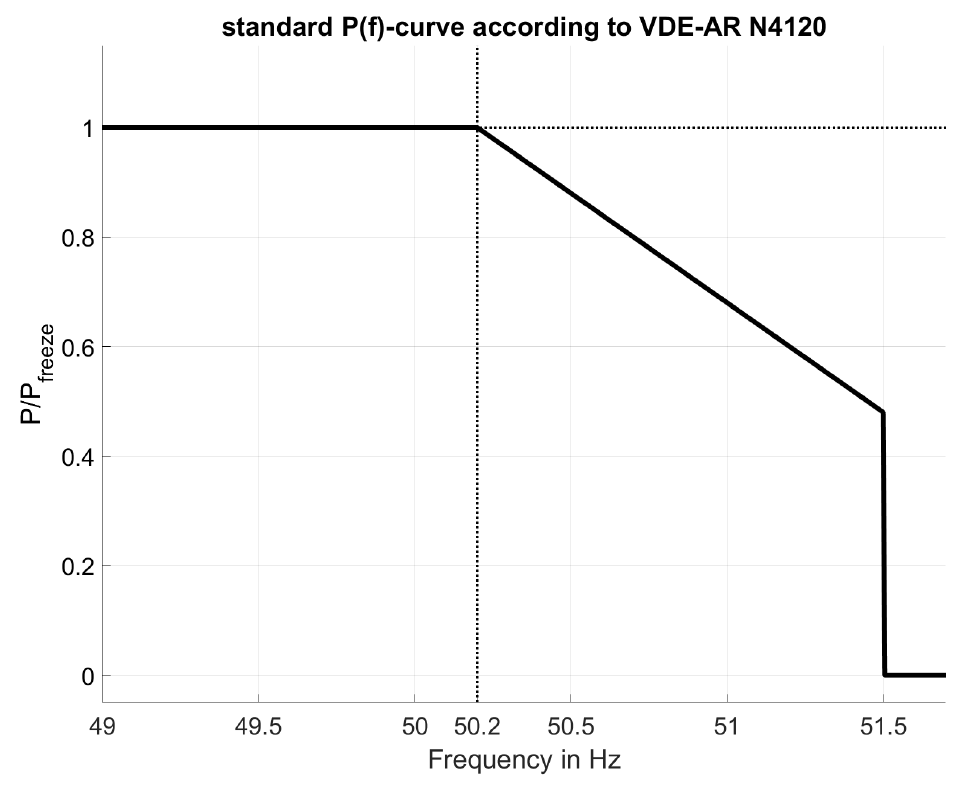
Figure 9. Active power characteristic of renewable generation at over